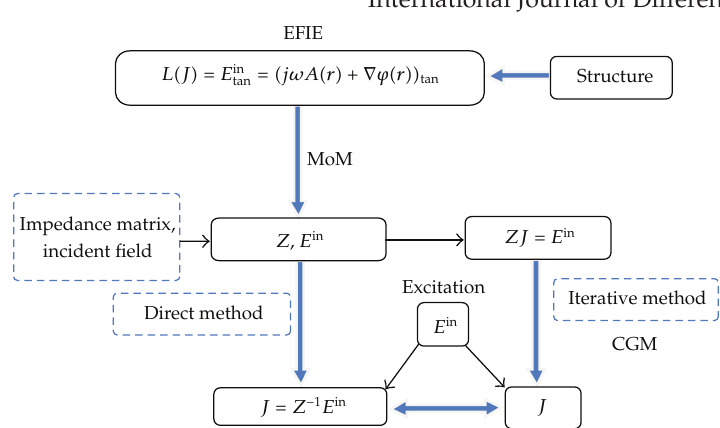
Figure 3: Solution for total current J : correspondence between direct MoM solution and iterative